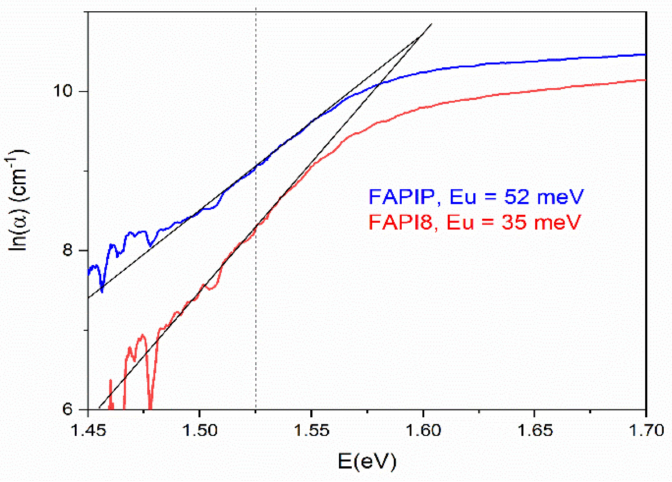
Figure 10. The absorption coefficient α versus photon energy E with the graphical estimation of the Urbach